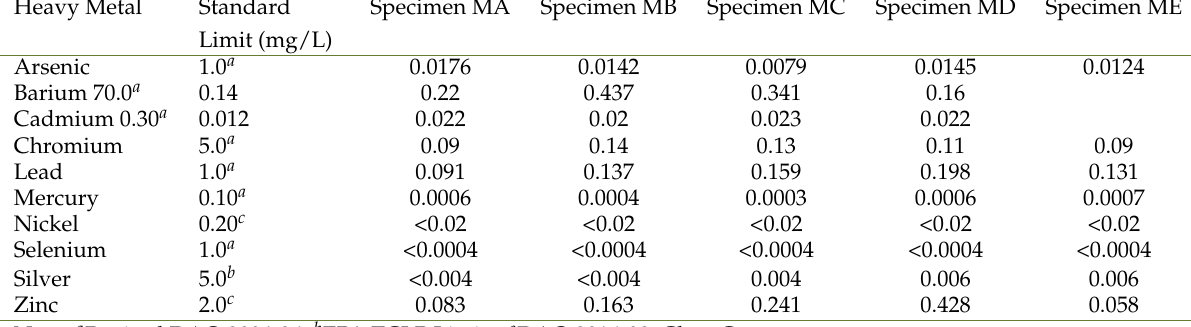
Table 7. TCLP test for the mortar mix